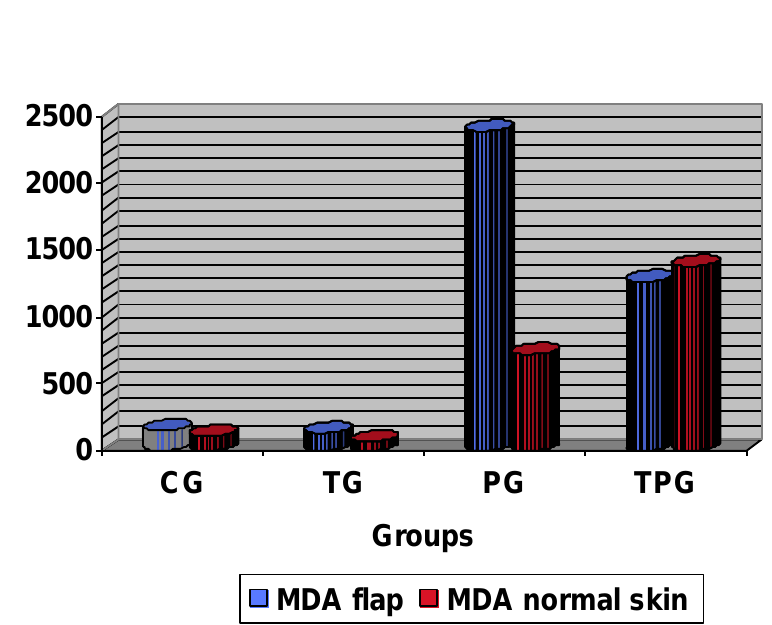
FIGURE 3 - Average concentration of malondialdehyde (ng/ml) measured from the flap and normal skin on the seventh postoperative